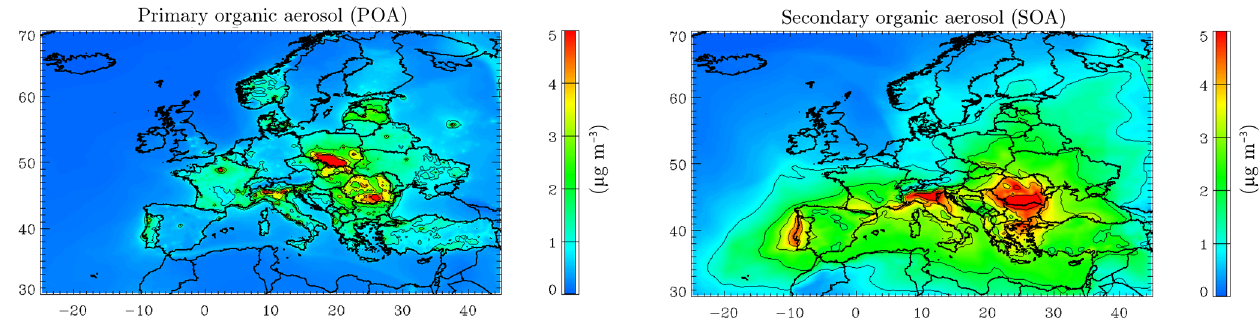
widespread with a visible north to south gradient (Fig.